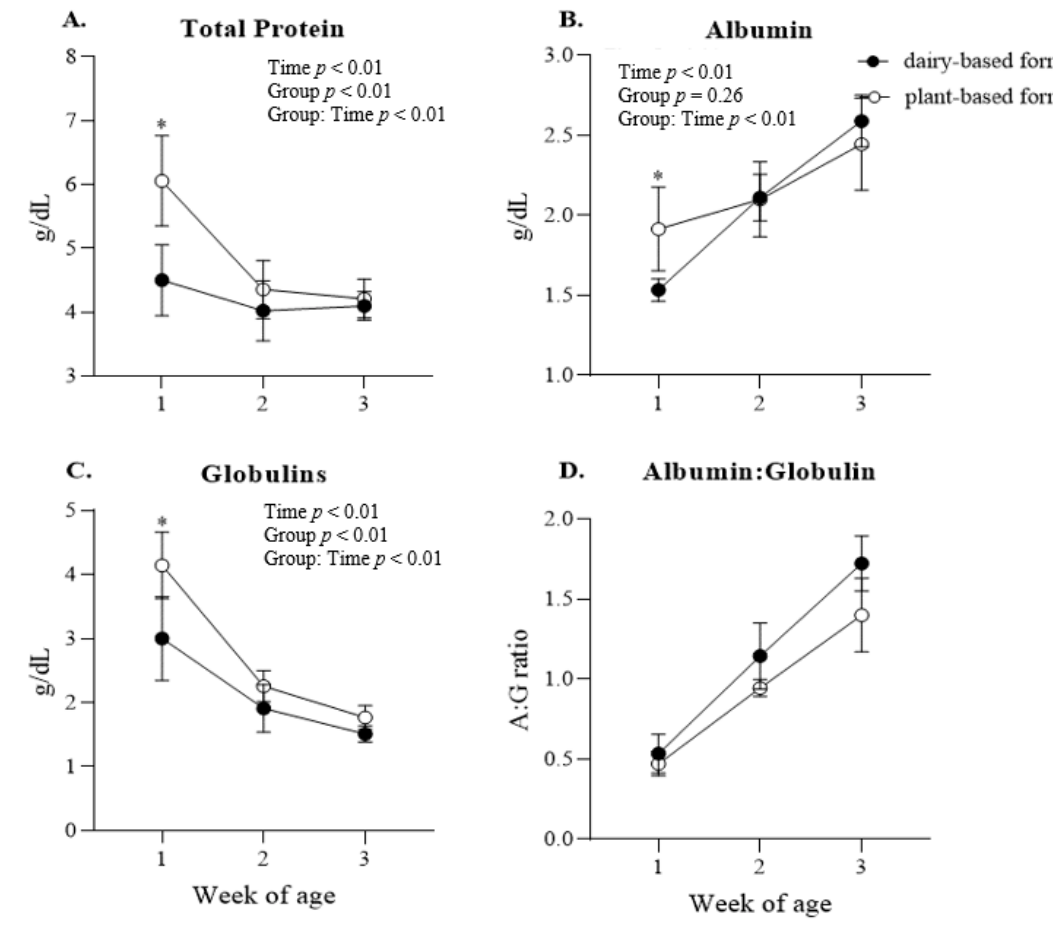
Figure 5. Average serum ( A ) total protein, ( B ) albumin, ( C ) globulins, ( D ) albumin:globulin ratio at 1, 2, and 3 weeks of age of piglets fed either a dairy-based (Similac Advance powder) or a plant-based (Else nutrition powder) formula ( n = 9/group) from postnatal day (PND) 2 until PND 21. * Represents the statistical difference between diet groups at the given time point.